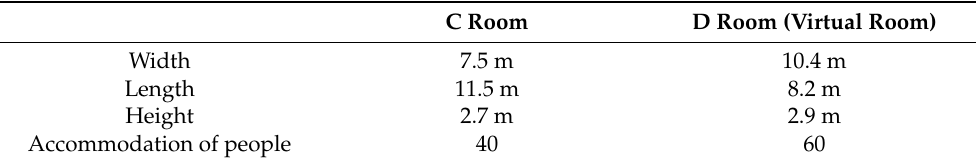
Table 3. Comparison of each room specification.